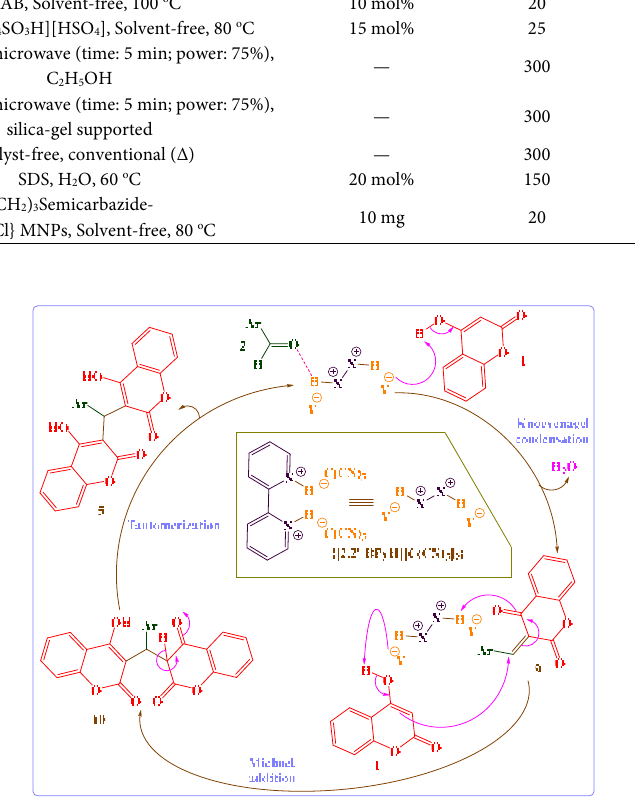
175 Nanochem Res 3(2): 170-177, Summer and Autumn 2018